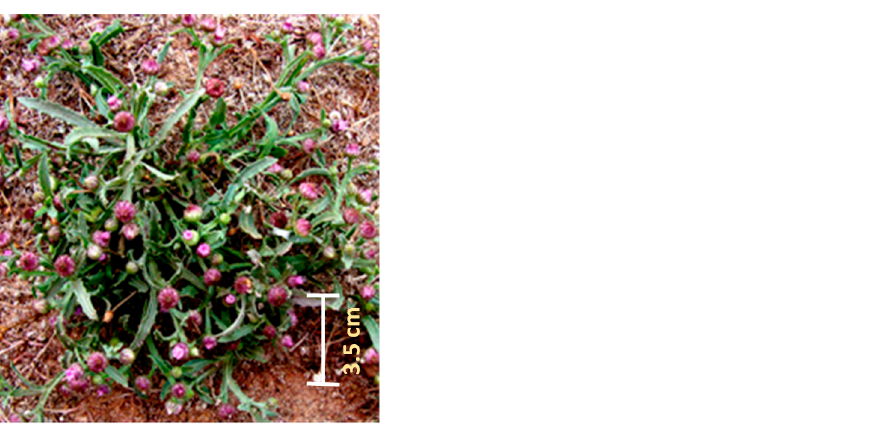
Figure 1. External morphology of Epaltes divaricata (L.) Cass. collected from the southwestern Ghats region of Tirunelveli, Tamil Nadu, India.